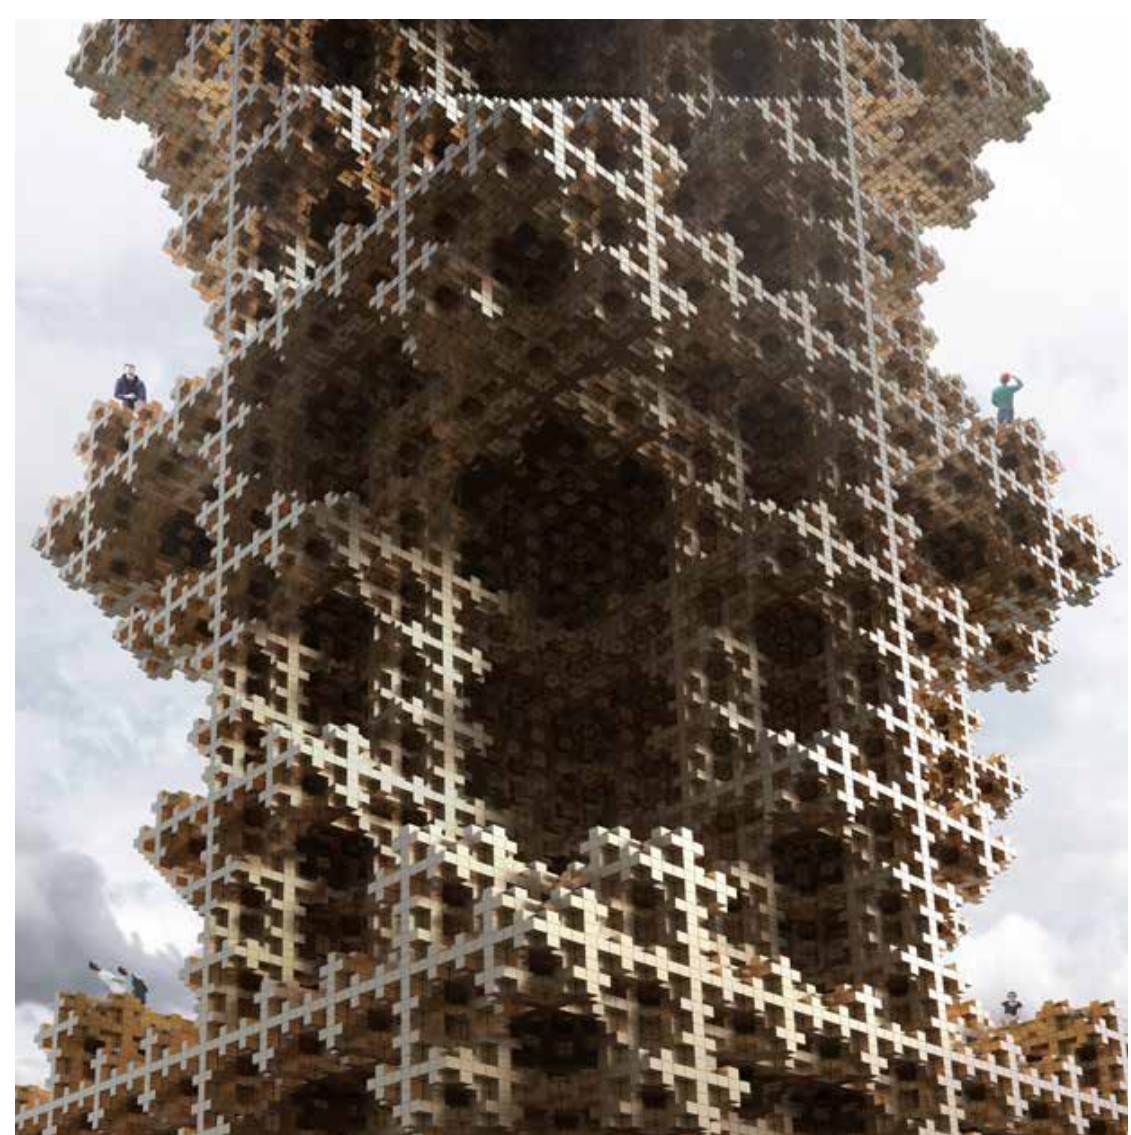
Figure 32: The Wall (2017). Digital Image. Design: Daniel Widrig Studio. Source: